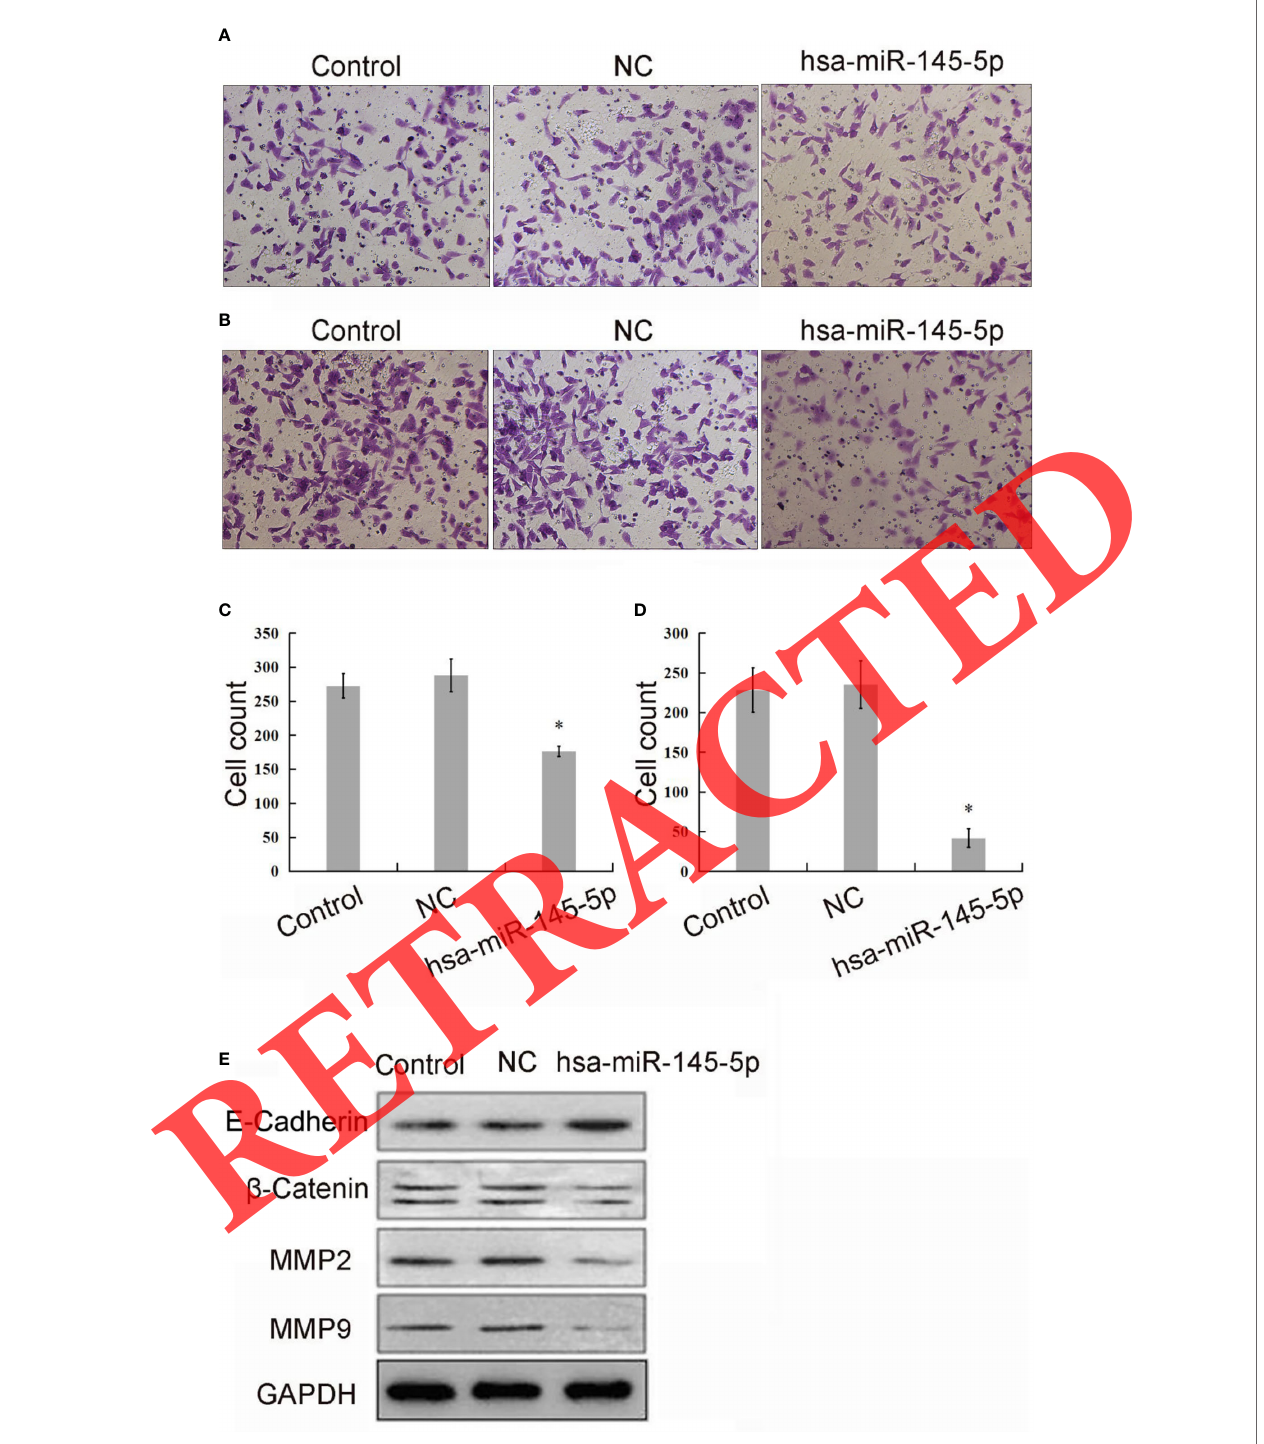
FIGURE 3 | Effect of miR-145-5p overexpression on cell migration and invasion. (A) A cell migration assay was performed on LNCaP cells overexpressing miR-145- 5p. (B) A cell invasion assay was performed on LNCaP cells overexpressing miR-145-5p. (C) The number of migrated cells in the control, NC, and miR-145-5p groups; *P < 0.05 compared with the NC and control groups. (D) The number of invaded cells in the control group; *P < 0.05 compared with the NC and control groups. (E) The expression of E-cadherin, b -catenin, MMP2, and MMP9 protein detected by western